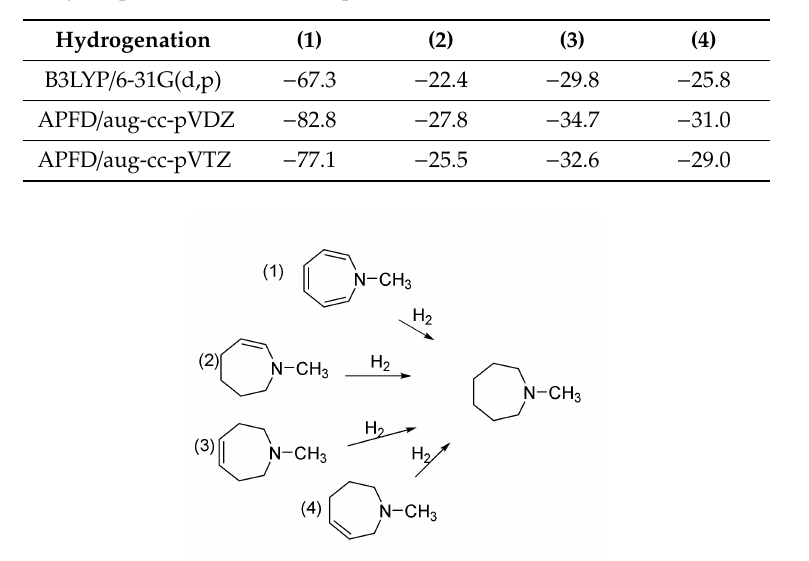
Table 10. Computed enthalpies of reaction (kcal / mol; 1.000 kcal = 4.184 kJ) for hydrogenation reactions (1)–(4) of N -methylazepine and its reduction